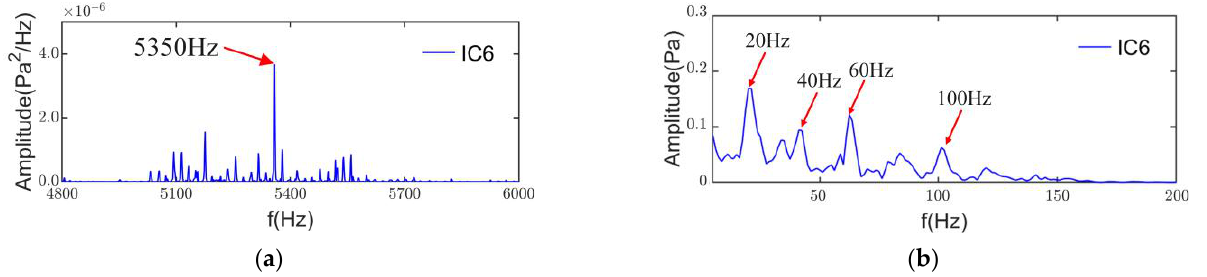
Figure 18. PSD and envelope spectrum of IC6: ( a ) PSD; ( b ) envelope spectrum